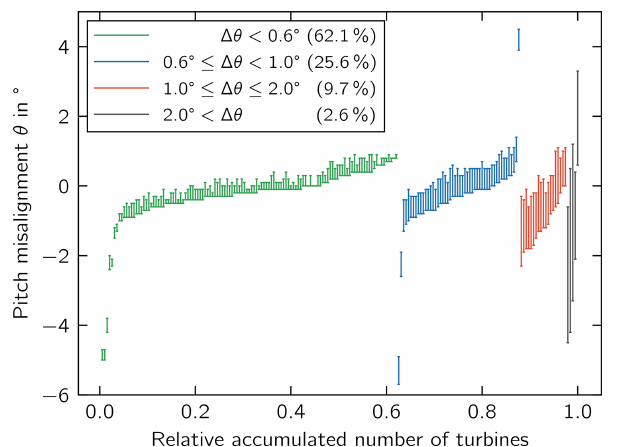
Figure 2. Identification of chord shape from measured coordinates.